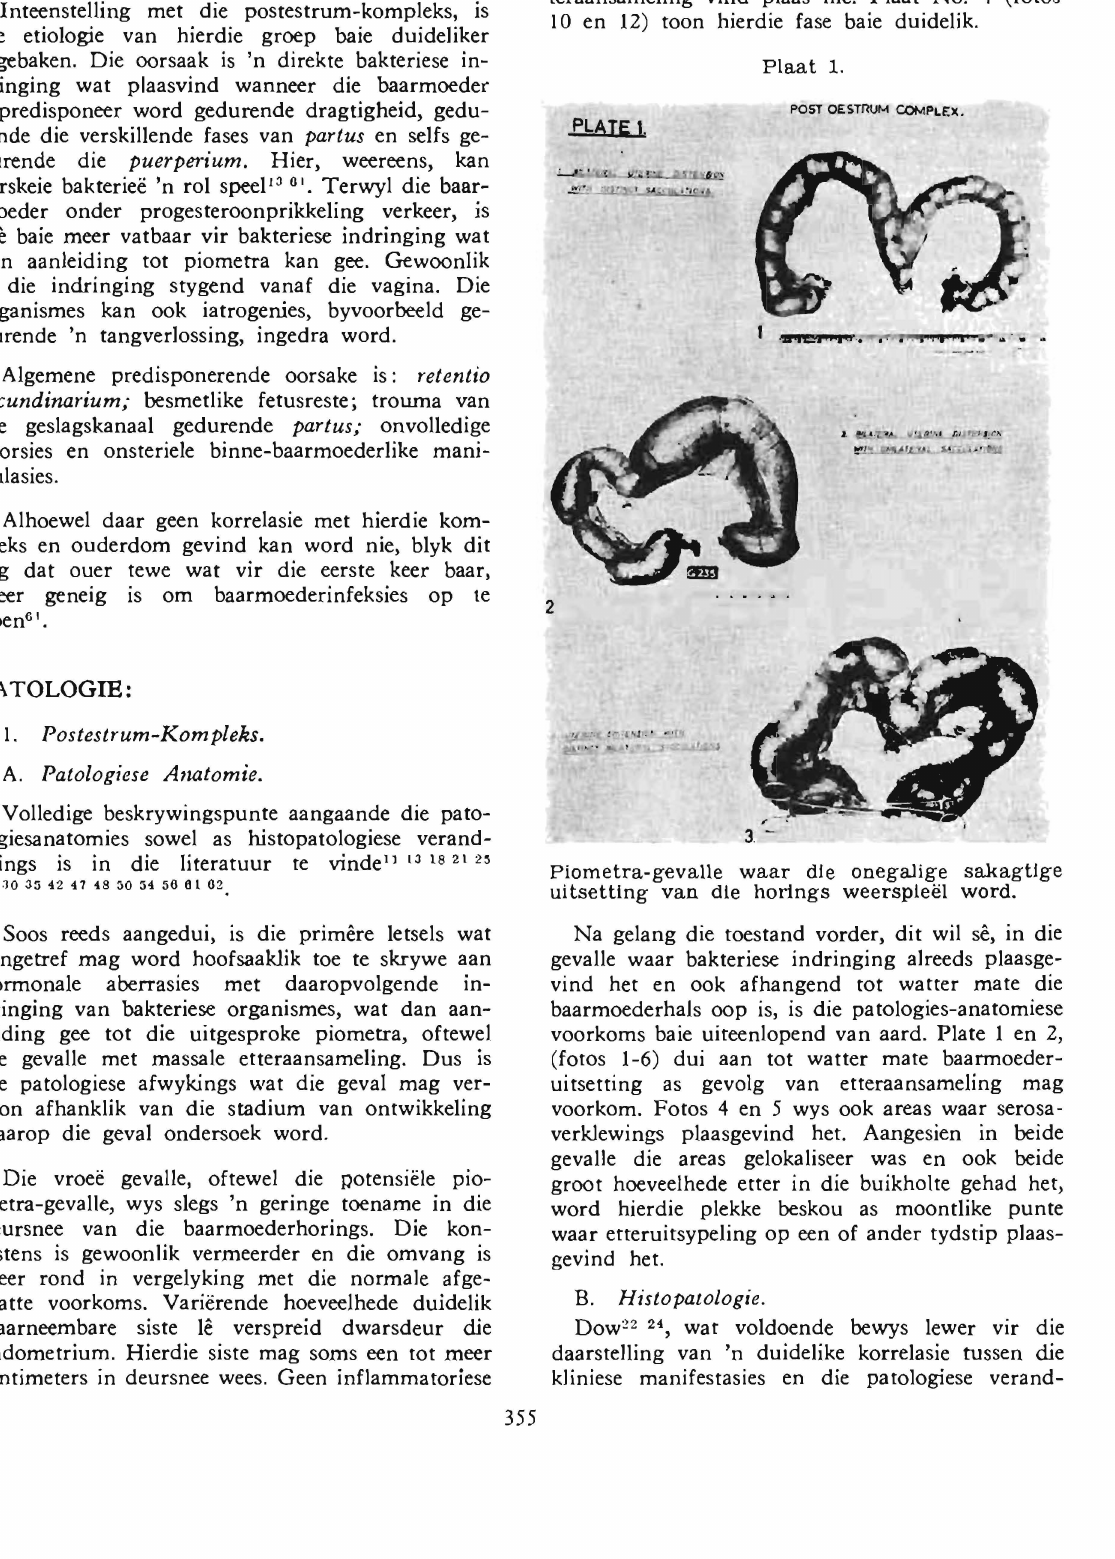
Inteenstelling met die postestrum-kompleks, is die etiologie van hierdie groep baie duideliker